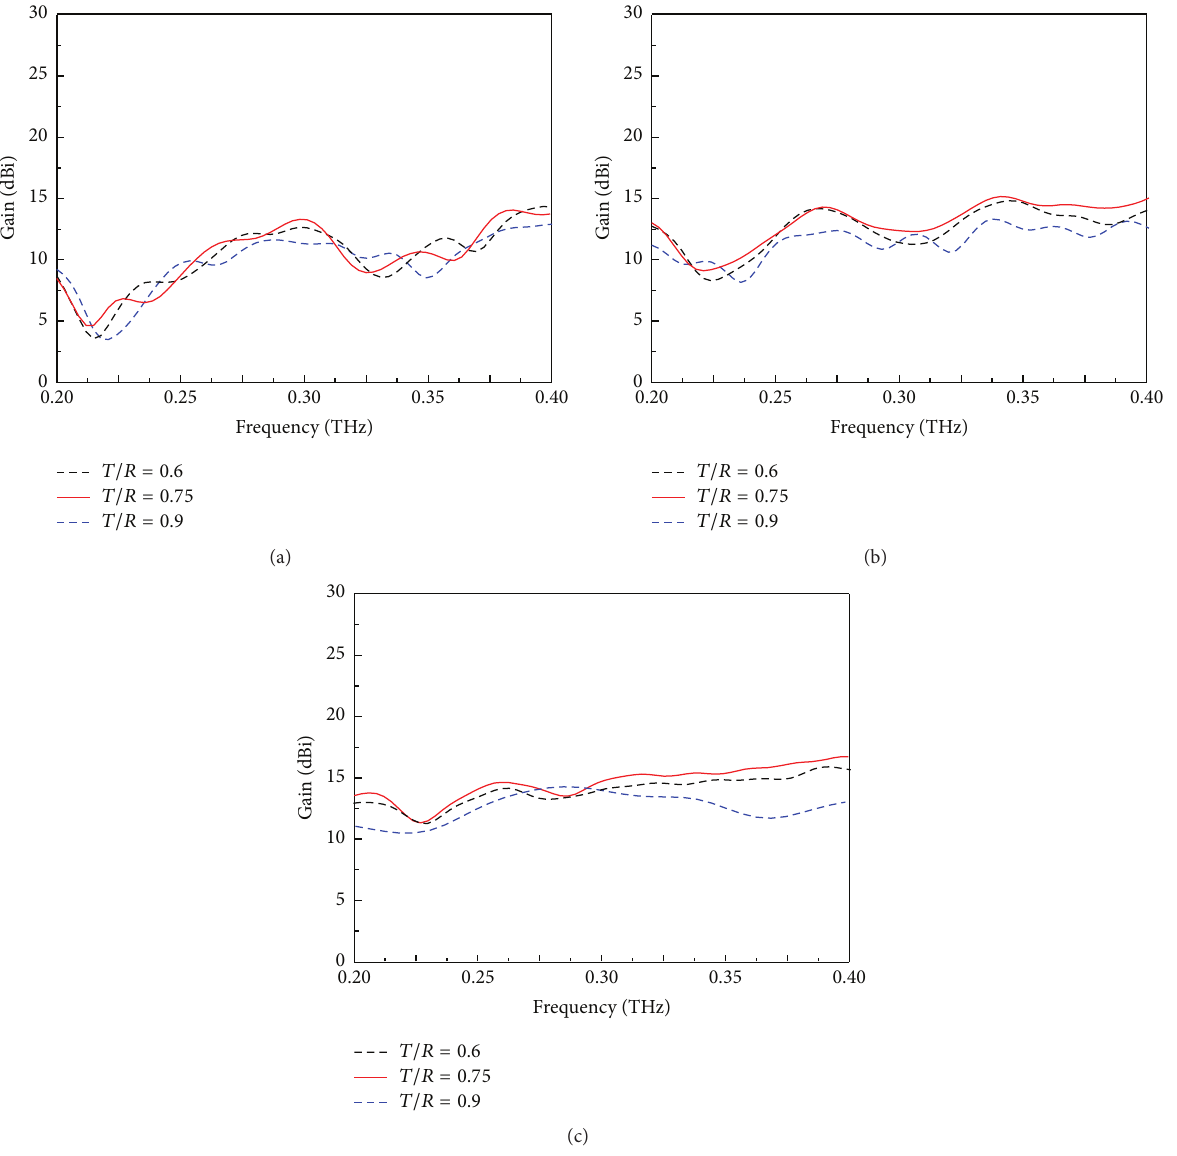
Figure 8: Comparison plots of antenna gain for quartz lenses with different 𝑇/𝑅 values of (a) 𝑅 = 0.8 𝜆 𝑜 , (b) 𝑅 = 1.2 𝜆 𝑜 , and (c) 𝑅 = 1.6 𝜆 𝑜 .